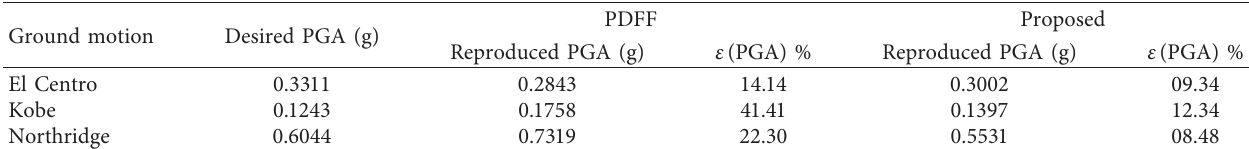
Table 9: Error in PGA reproduction for different earthquake records (loaded table). Ground